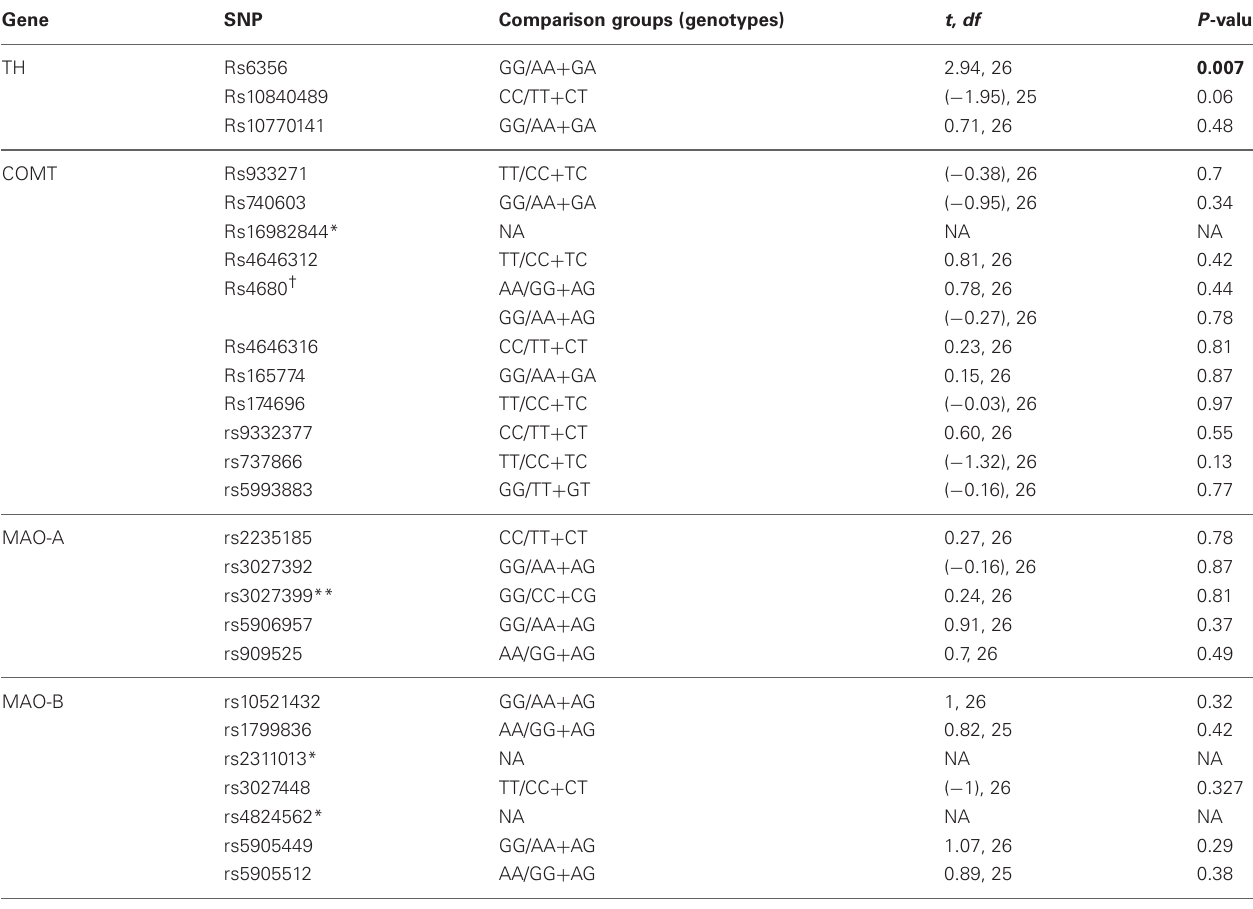
Table A1 | Univariate associations ( t -tests) of tagging SNPSs and UPDRS scores. Gene SNP Comparison groups (genotypes)